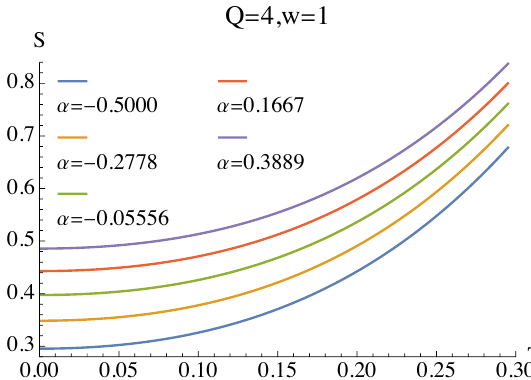
Figure 4 . HEE vs T in different value of the α when Q = 4 and width w = 1 .